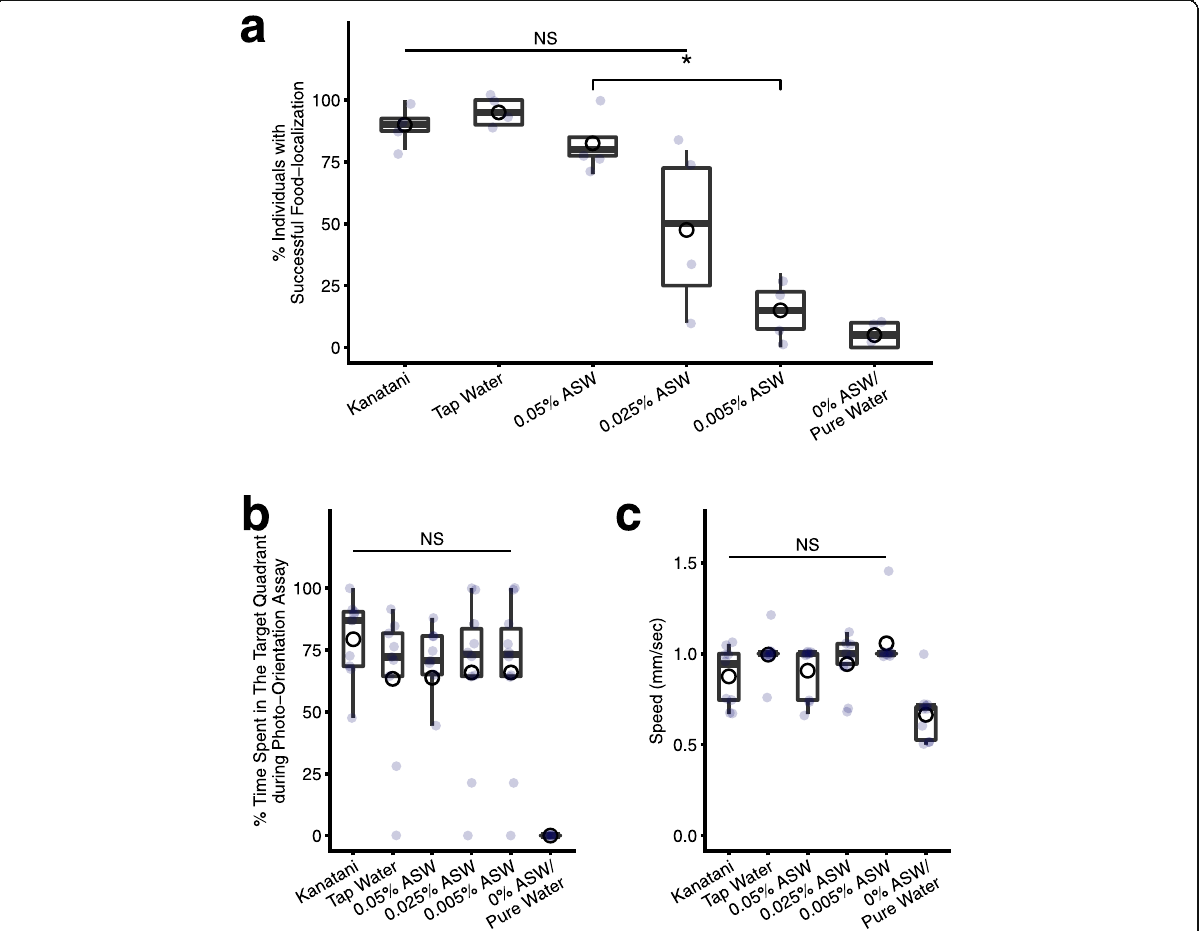
Fig. 2 Breeding water affects the food-localization behavior. a . The percent of individuals that reached the food (piece of liver) within 10 min is shown as a box-and-whisker plot with mean (open circles). n = 10; 4 independent experiments. Although there were no significant differences (NS by Kruskal-Wallis test) among planarians grown in Kanatani water, tap water, 0.05% ASW, and 0.025% ASW (Kruskal-Wallis test), the food- localization of planarians cultured in breeding water containing a lower concentration (0.005% ASW) or absence (0% ASW/pure water) of ions was suppressed. *, p < 0.05 (Wilcoxon test). b . The time spent in the target quadrant during the photo-orientation assay. Only the planarians that were grown in the 0% ASW/pure water showed impairment of the photo-orientation behavior, while the others were unaffected. There were no significant differences (NS) among planarians grown in Kanatani water, tap water, 0.05% ASW, 0.025% ASW, and 0.005% ASW (Kruskal-Wallis test). c . The motor activity indicated by the average speed. Although the speed of planarians grown in the pure water was slightly decreased, the others were unaffected. There were no significant differences (NS) among the speeds of planarians grown in Kanatani water, tap water, 0.05% ASW, 0.025% ASW, and 0.005% ASW (Kruskal-Wallis